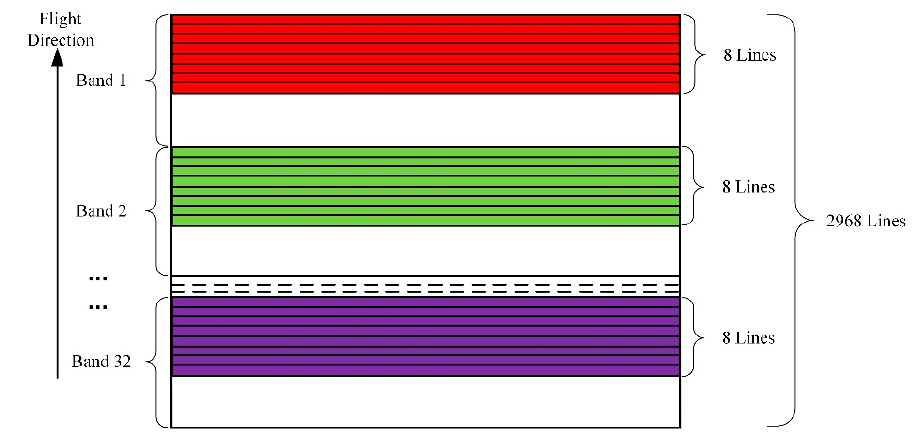
Figure 1. Focal plane arrangement for the hyperspectral camera.